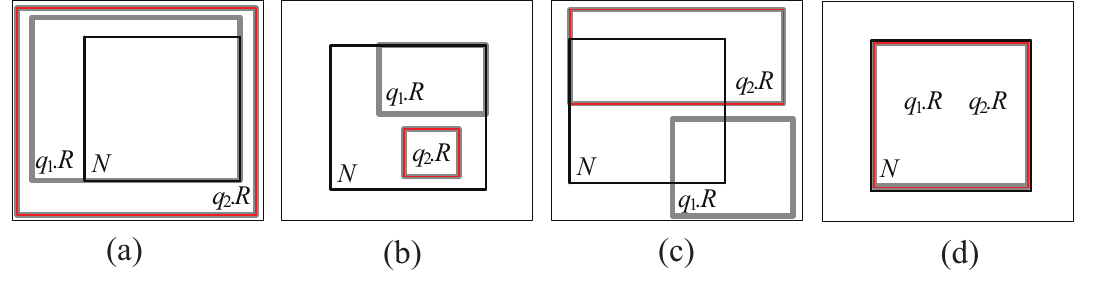
.R and q .R cover N ; ( b ) q 1 2